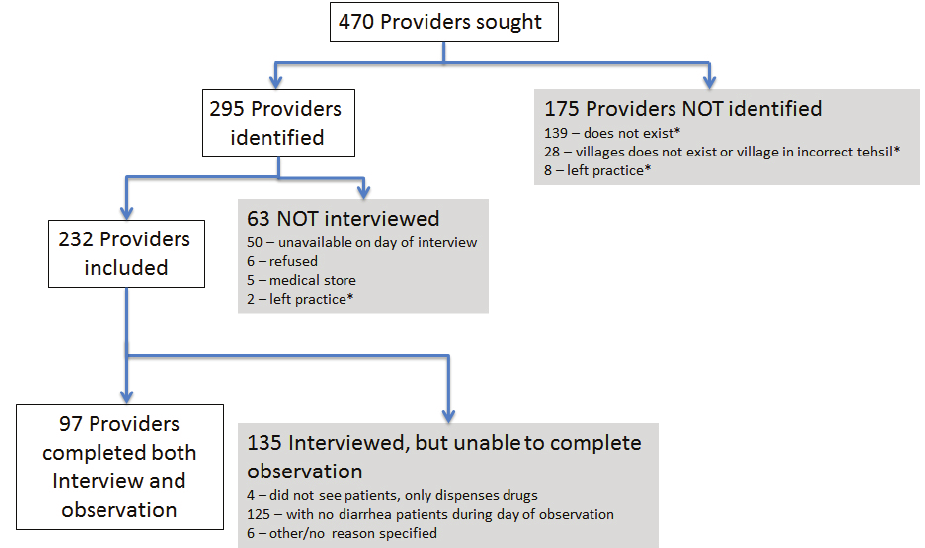
Figure 1. Study sample. Asterisk indicates that the information collected from village administra- tive heads, other providers, and local